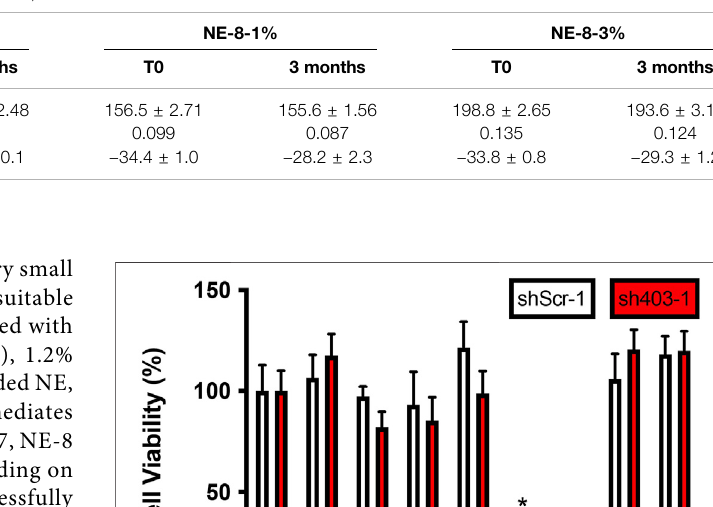
TABLE 2 | Physico-chemical characteristics of selected NEs: unloaded one, and those loaded with the effective NL. NE-0